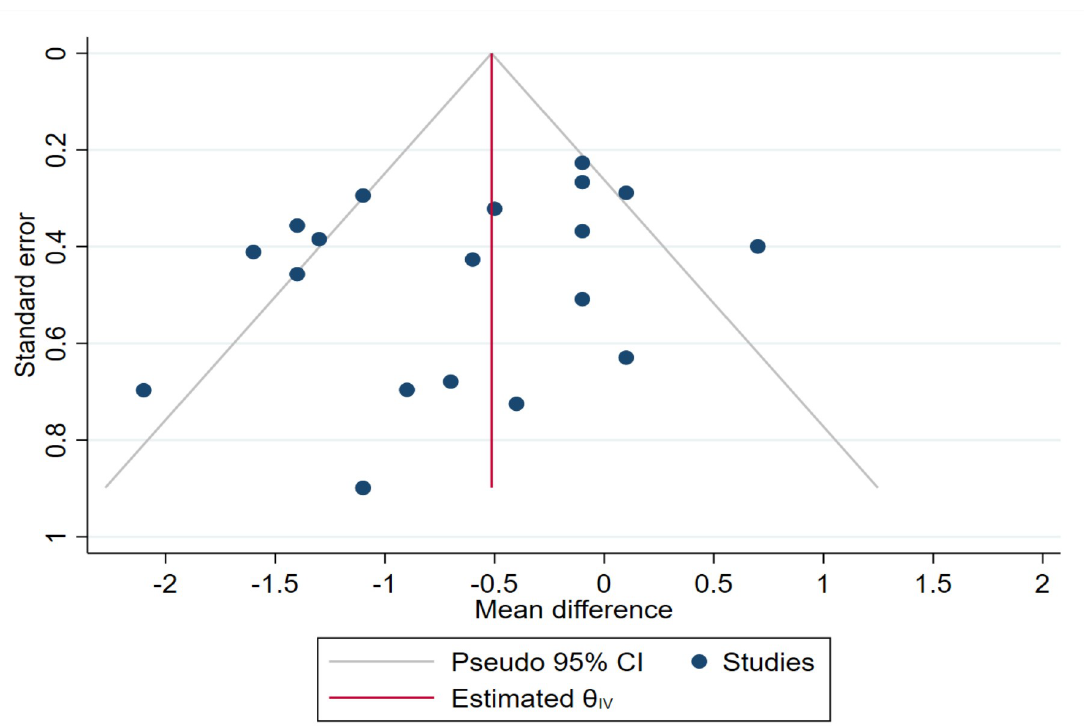
Fig 3. Funnel plot of HbA1c (%) during CIPII treatment compared to that during control treatment (CSII). The funnel plot includes diagonal lines representing expected distribution of studies in the absence of heterogeneity (95% of the studies should lie within these diagonal lines). The lines are not strict 95% confidence interval, therefore, referred as ‘pseudo 95%